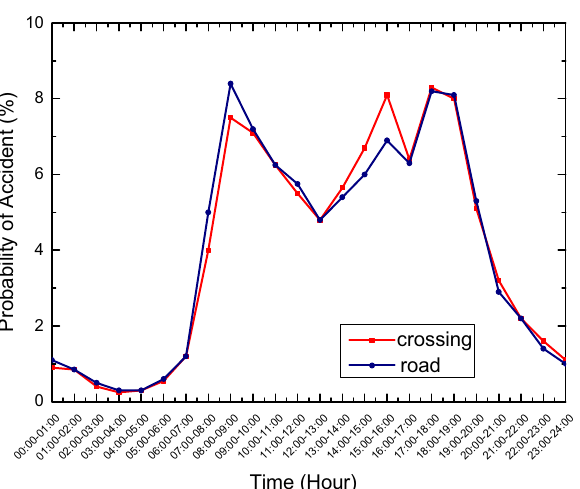
Figure 1. The accident incidence rate in hours of crossing and road in shanghai are fitted by linear relationship. It can be seen from the figure that the value is high from 6 a.m. to 8